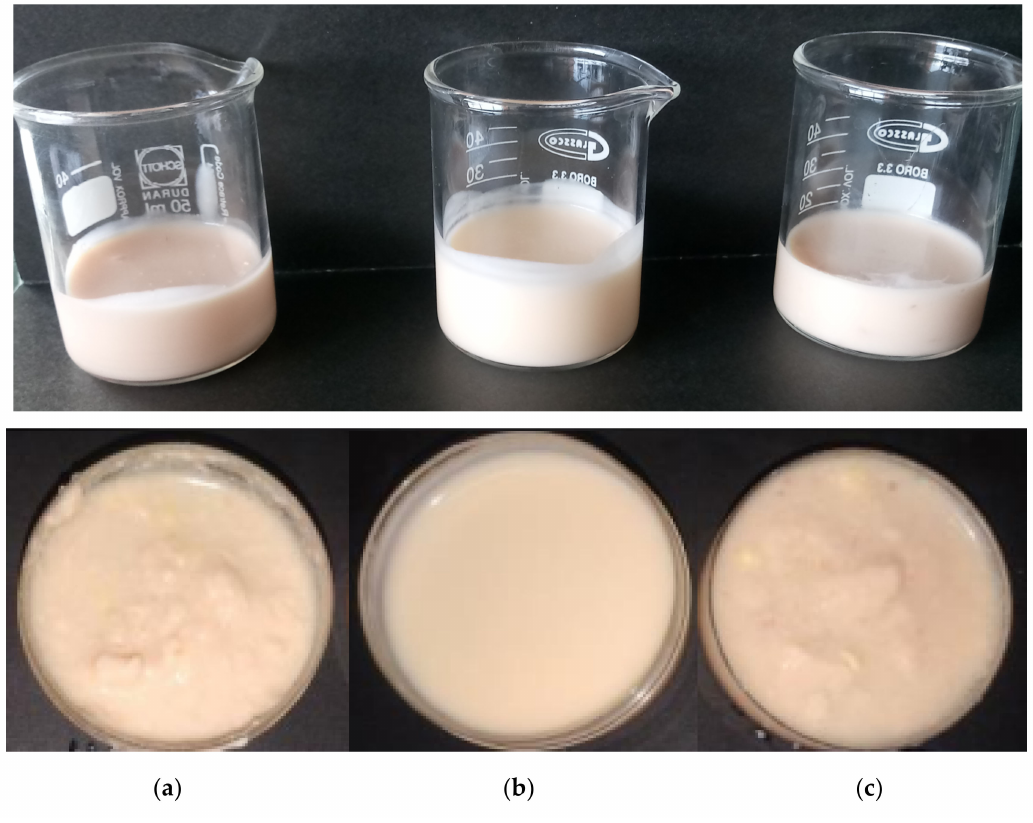
Figure 4. Appearance comparison among Y-SD-OFI ( a ), Y-C ( b ), and Y-SD-AV ( c ) before ( top row) and after storage for 25 days in the dark at 4 ◦ C ( bottom